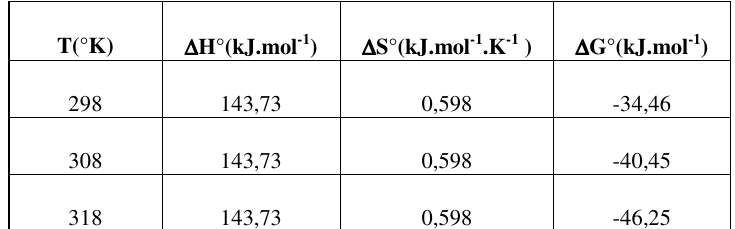
Table 4. Thermodynamic parameters of